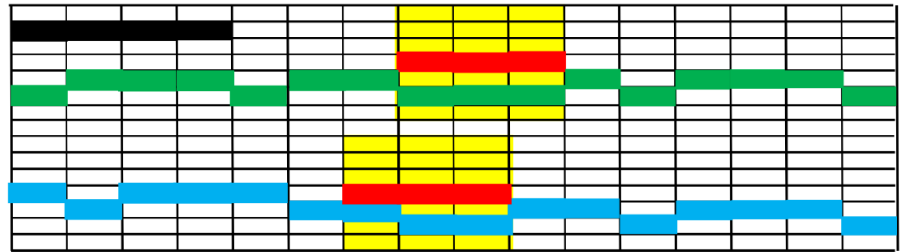
Figure 5. Working principle of horizons fusion. The black, green, and blue points represent the detailed horizon points. Red points denote the main horizon points. Yellow rectangle shallowed areas show the vertical neighborhood of the red points.